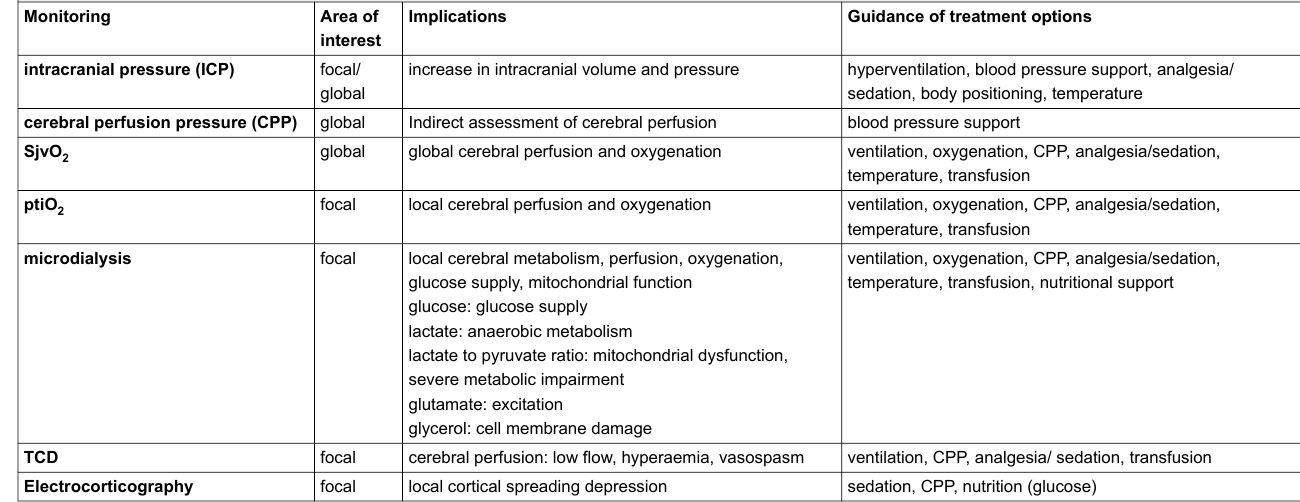
Table 1: Neuromonitoring: areas of interest, implications and guidance of treatment options. Monitoring Area of interest